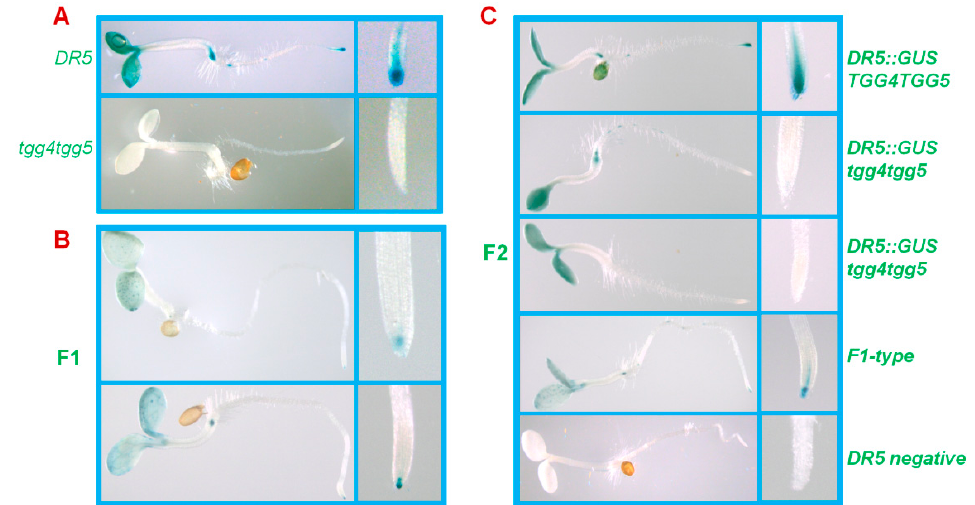
Figure 6. The role of AtTGG4 and AtTGG5 in auxin biosynthesis. ( A ) GUS staining of the parents: DR5::GUS and tgg4tgg5 ; ( B ) representative F1 plants; and ( C ) representative plants of the segregating F2 generation. Zoom-in images of the root-tips were presented beside each seedling.